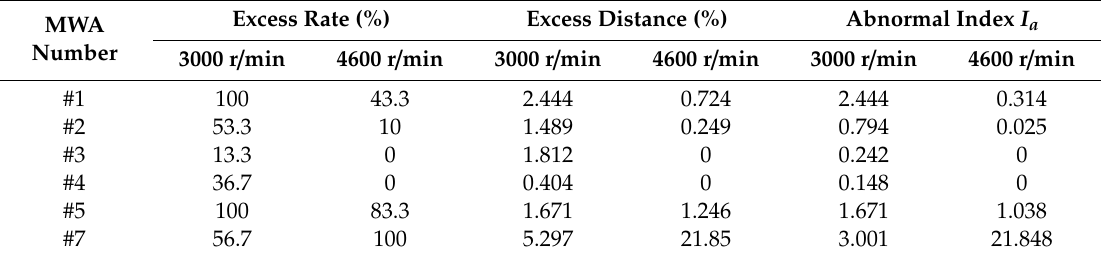
Table 3. Excess rates of seven tested MWAs with the same structural parameters at a rotating speed of 4600 r /